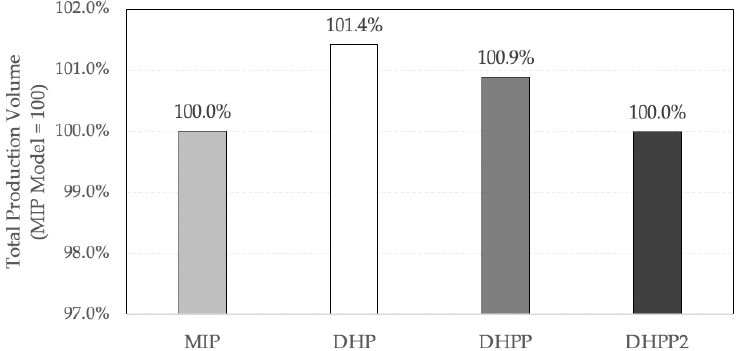
Figure 6. Average Production Volume from the Models.